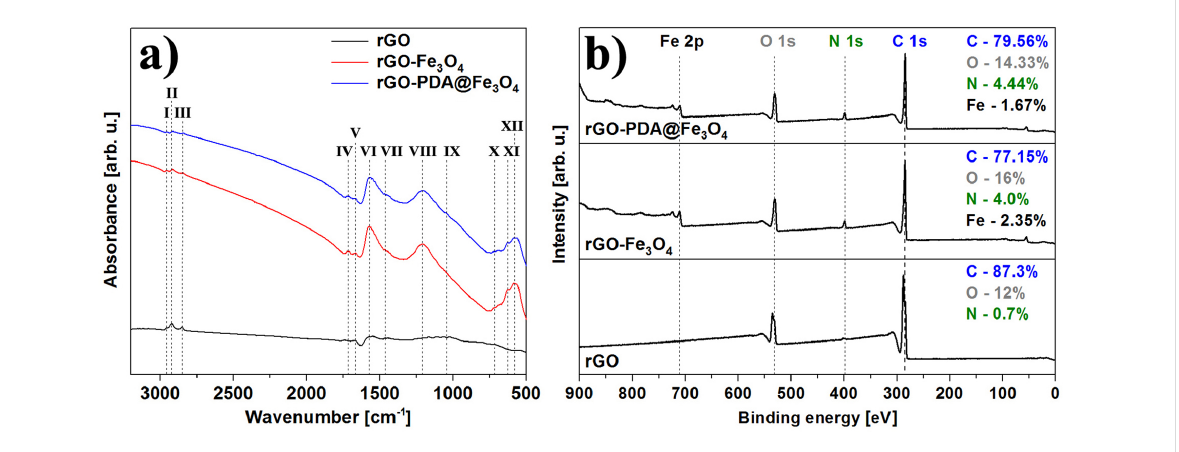
Figure 5: FTIR absorption (a) and XPS survey (b) spectra of rGO, rGO-Fe 3 O 4 and rGO-PDA@Fe 3 O 4 aerogel samples.